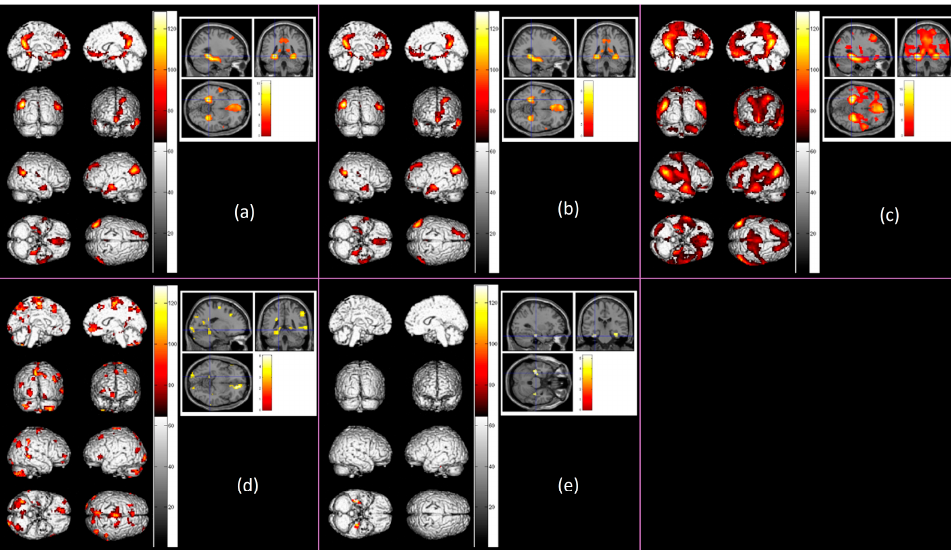
Figure 6. Significant cluster-level activations for relational processing of scenes (N > S contrast), at p < 0.05 ( FDR -corrected) with k ≥ 20, after adjusting for gray matter probability, signal-to-fluctuation- noise (SFNR), and accuracy (ACC) performance. In the figure, from the top left panel: ( a ) Significant activation among older adults ( n = 33) for relational processing of scenes (N > S contrast); ( b ) Sig- nificant activation among older high performers ( n = 24) for relational processing of scenes (N > S contrast); ( c ) Significant activation among young adults ( n = 48) for relational processing of scenes (N > S contrast); ( d ) Significant activation for young versus older adults ( n = 81) for relational processing of scenes (N > S contrast); ( e ) Significant activation for young versus older low performers ( n = 57) for relational processing of scenes (N > S contrast).